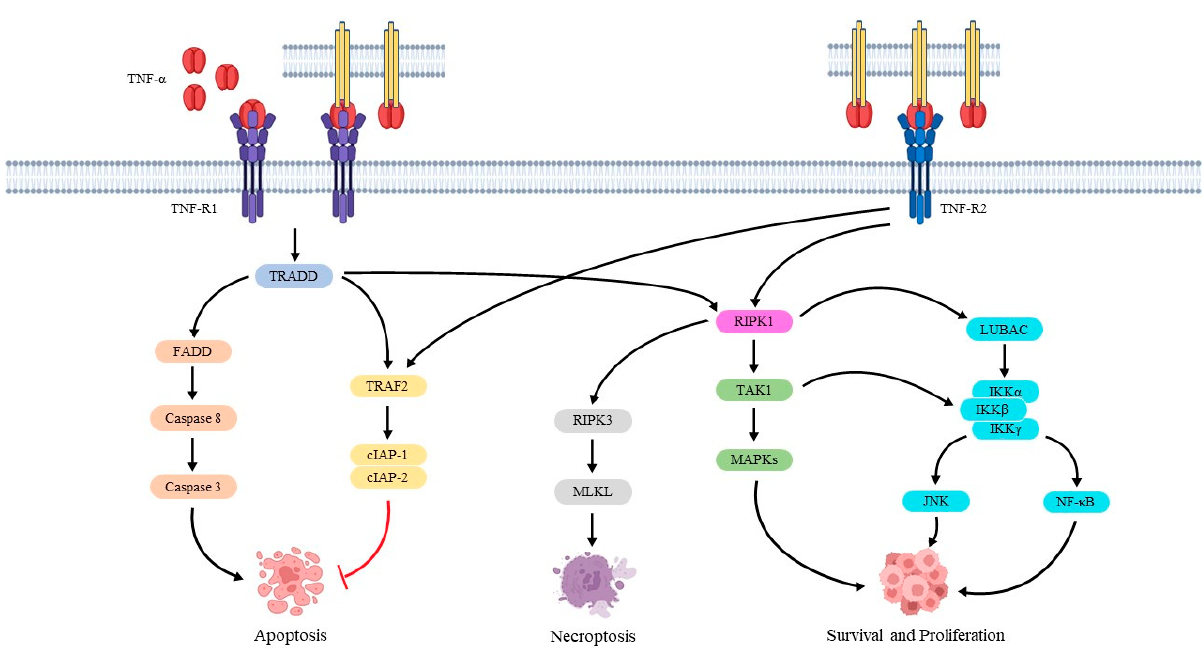
Figure 1. Signaling pathways of TNF- α .